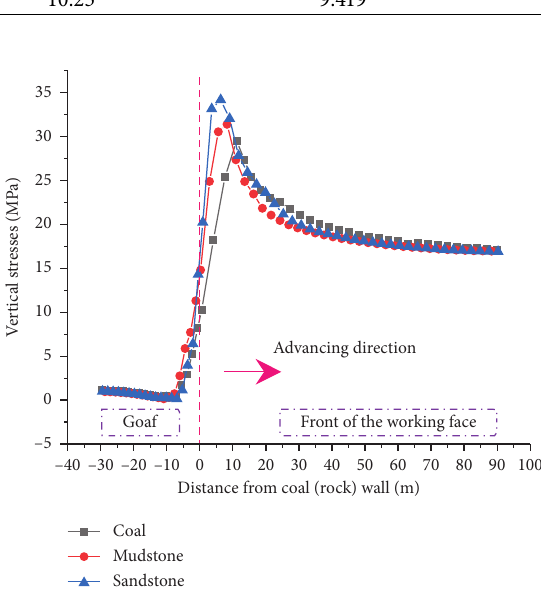
Figure 3: Distribution curves of preabutment pressure in front of stope with different stratum lithology